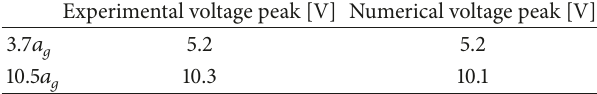
Table 3: Experimental versus numerical